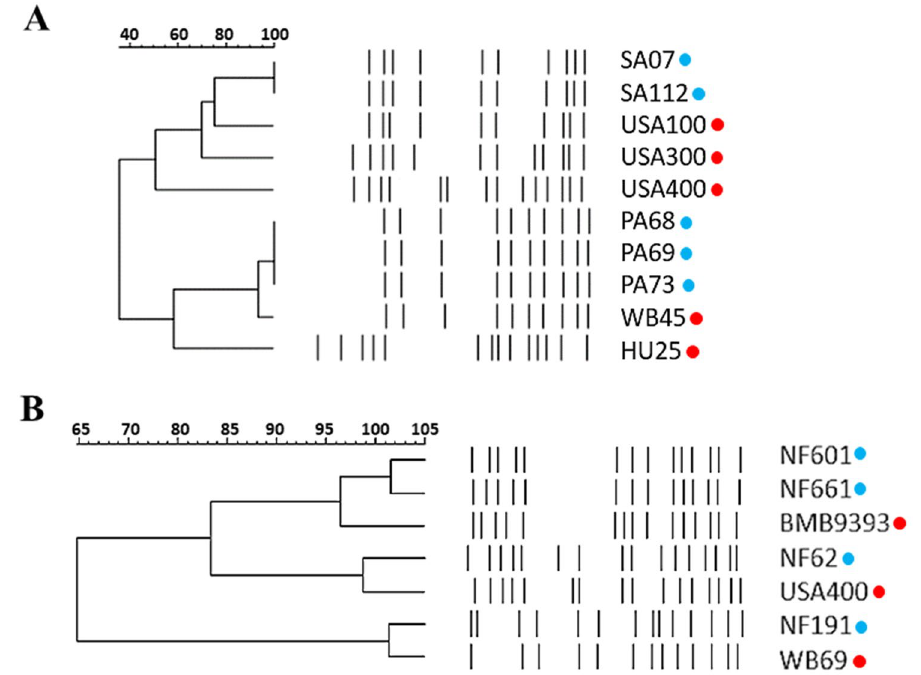
Figure 1. Pulsed-field gel electrophoresis (PFGE) of the Sma I-fragmented genomic DNA of MRSA isolates recovered from healthy and infected dogs in the state of Rio de Janeiro (red circles). ( A ) Dog isolates from Rio de Janeiro city and ( B ) dog isolates from Campos de Goytacazes city. USA100, USA300, USA400, WB45 and WB69 (USA1100), and BMB9393 and HU25 (BEC) were representatives of the MRSA international clones used for comparison purposes (blue circle). Dendrograms were generated from the PFGE patterns using GelCompar II software version 6.5.